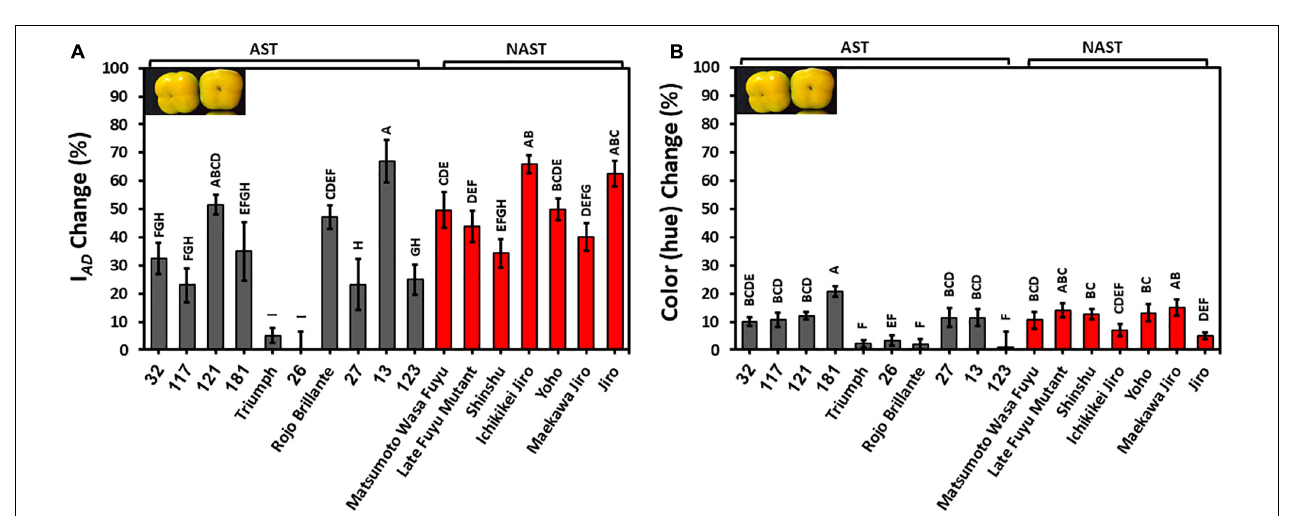
FIGURE 4 | Correlation between chlorophyll (I AD ) and color (hue) of persimmon cultivars for harvests of 2017 and 2019. (A) Correlation between hue and I AD of harvest 2017; (B) Correlation between hue and I AD of harvest 2019. Red and black dots represent the non-astringent and astringent cultivars, respectively.